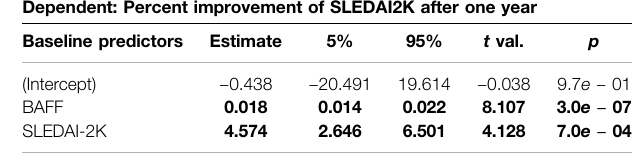
TABLE6| LinearregressionmodeltopredictpercentimprovementofSLEDAI-2K after one year, dependent on SLEDAI-2K at baseline and BAFF levels measured at